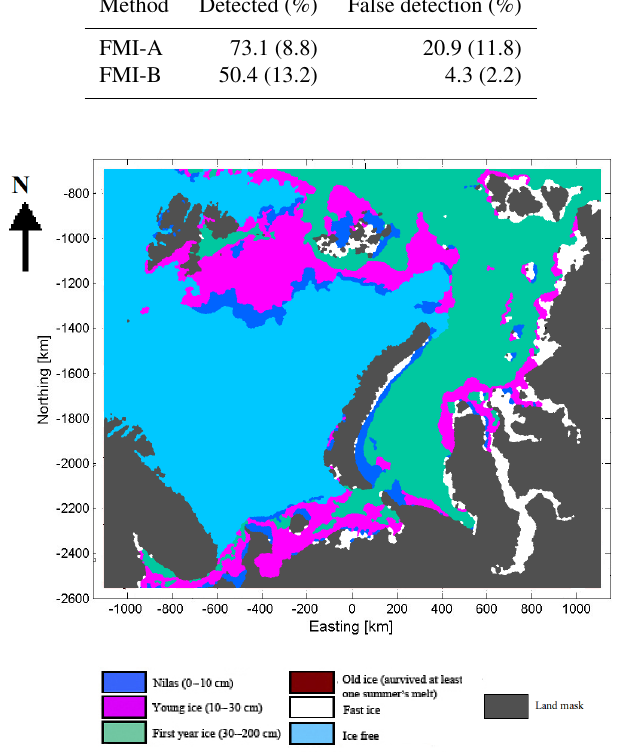
Figure 6. AARI ice chart of 8 March 2016, translated into the polar stereographic projection used in this study and cropped to the study